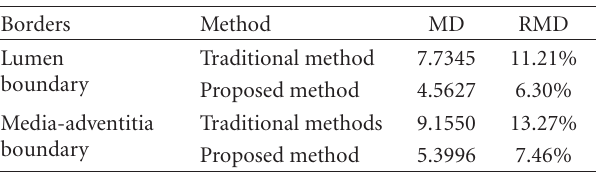
Table 2: Quantitative comparison of results segmented from real